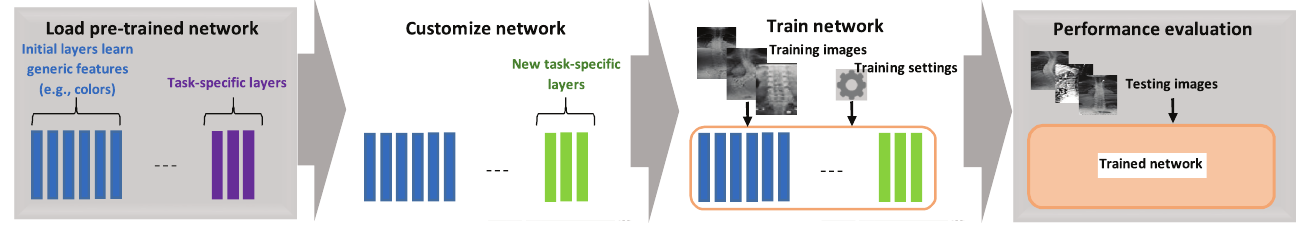
Fig 1. A graphical abstract of the transfer deep learning